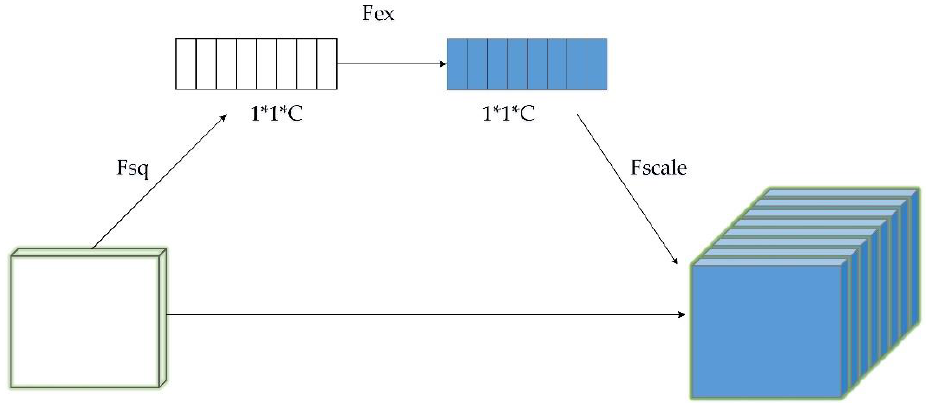
Figure 7. The framework of SENet.